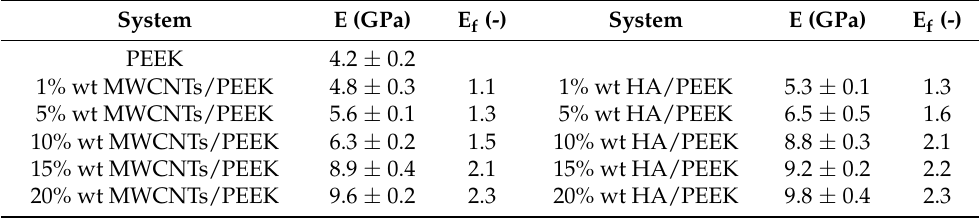
Table A3. Values of the Young modulus E and the corresponding enhancement factor E f (=E of the (nano)composite/E of the pristine polymeric matrix) for the system based on poly(ether ether ketone) (PeeK) and different loadings of multi-wall carbon nanotubes (MWCNTs)